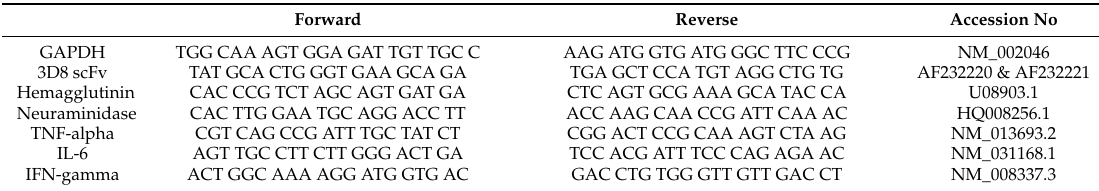
Table 1. Specific primers for